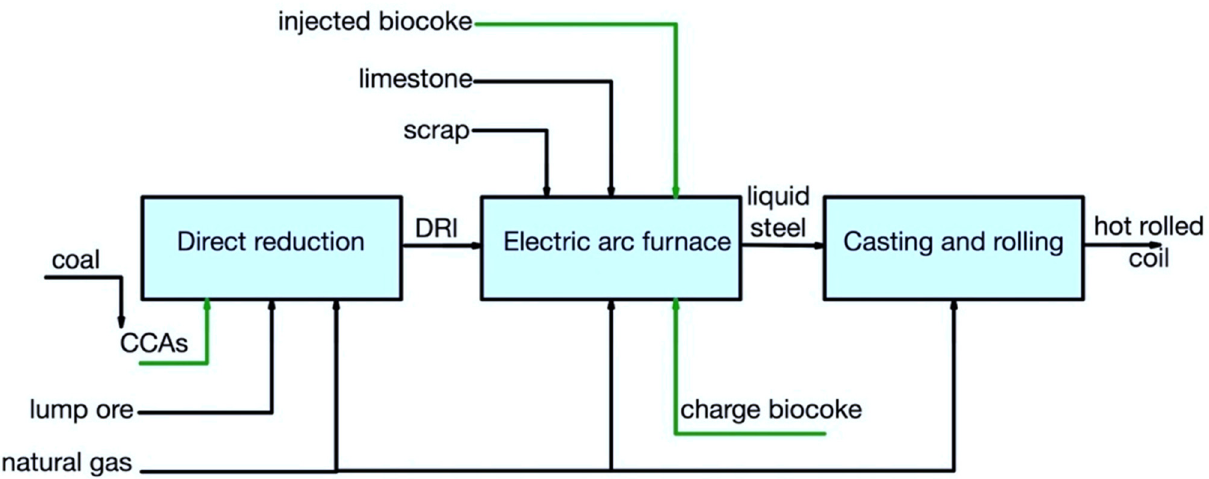
Figure 6. Main pathways for using secondary carbon bio-carriers in the DRI/EAF route.